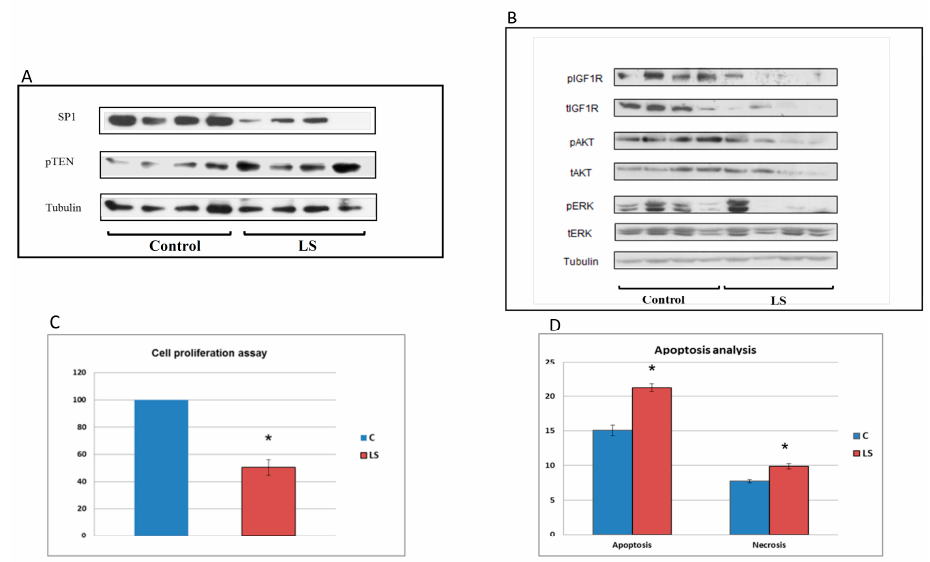
Figure 4. Analysis of signaling pathways associated with cancer protection in LS. ( A ) Western blot analysis of Sp1 and pTEN levels in LS-derived and control lymphoblastoids. Lymphoblastoid cell lines of four LS patients and four controls were lysed and extracts were electrophoresed through SDS-PAGE. Blots were incubated with antibodies against Sp1 and pTEN. The lanes correspond to individual controls and patients. ( B ) Western blot analysis of downstream mediators of IGF1 action in LS. Cell extracts were resolved on SDS-PAGE and membranes were incubated with antibodies against phospho- and total-IGF1 receptor (IGF1R), phospho- and total-AKT and phospho- and total-ERK. Tubulin levels were measured as a loading control. ( C ) Cell proliferation of LS and control cells. Proliferation of LS- and control-derived lymphoblastoid cells was assessed using an XTT colorimetric kit. The statistical significance of differences between groups was assessed by Student’s t -test. Legend: *, significantly different versus control ( p < 0 . 05); red bars, LS; blue bars, controls. ( D ) Basal apoptosis and necrosis of LS and control cells. Apoptosis and necrosis were measured by flow cytometry analysis after staining cells with an annexin-V antibody and propidium iodide (PI). Necrotic cells were stained with PI as well as annexin V; apoptotic cells were stained only with annexin V. The figure was adapted from